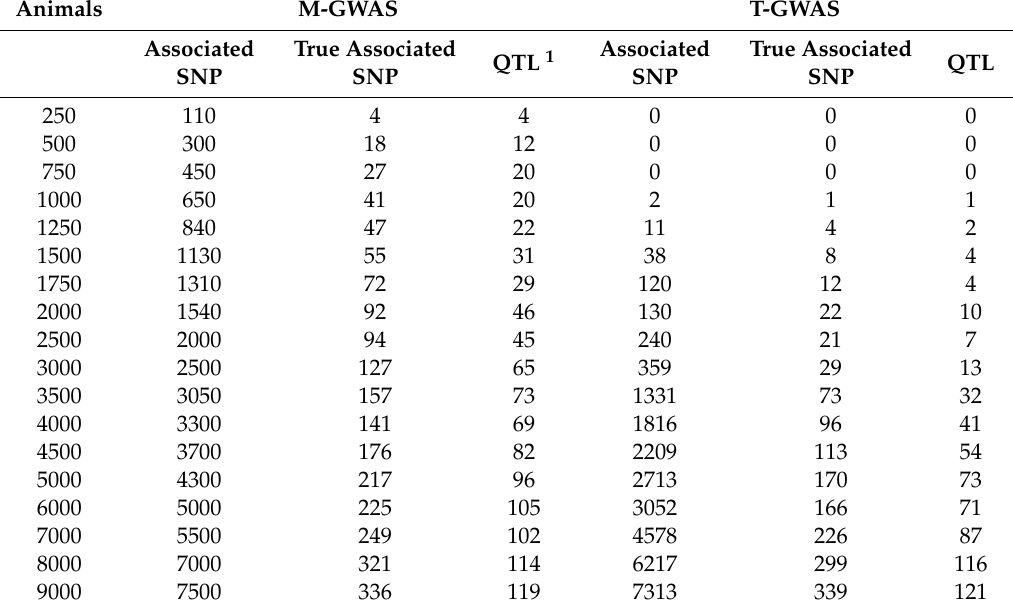
Table 1. Number of detected QTLs, false and true associated markers in the simulated dataset as the number of involved animals increases both for the multivariate (M-GWAS) and the traditional (M-GWAS) genome-wide association studies